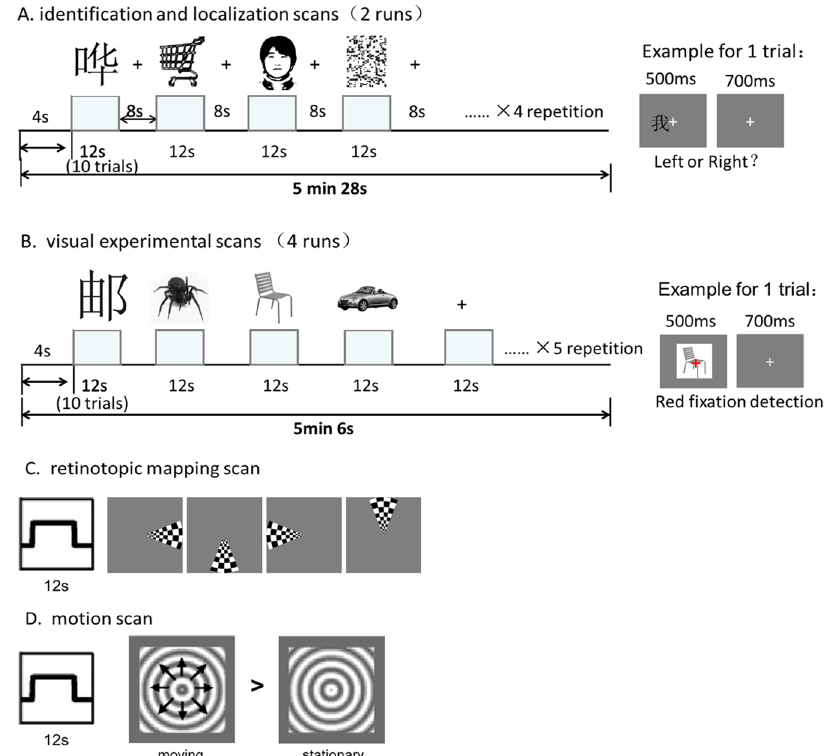
Figure 6. Experiment design and